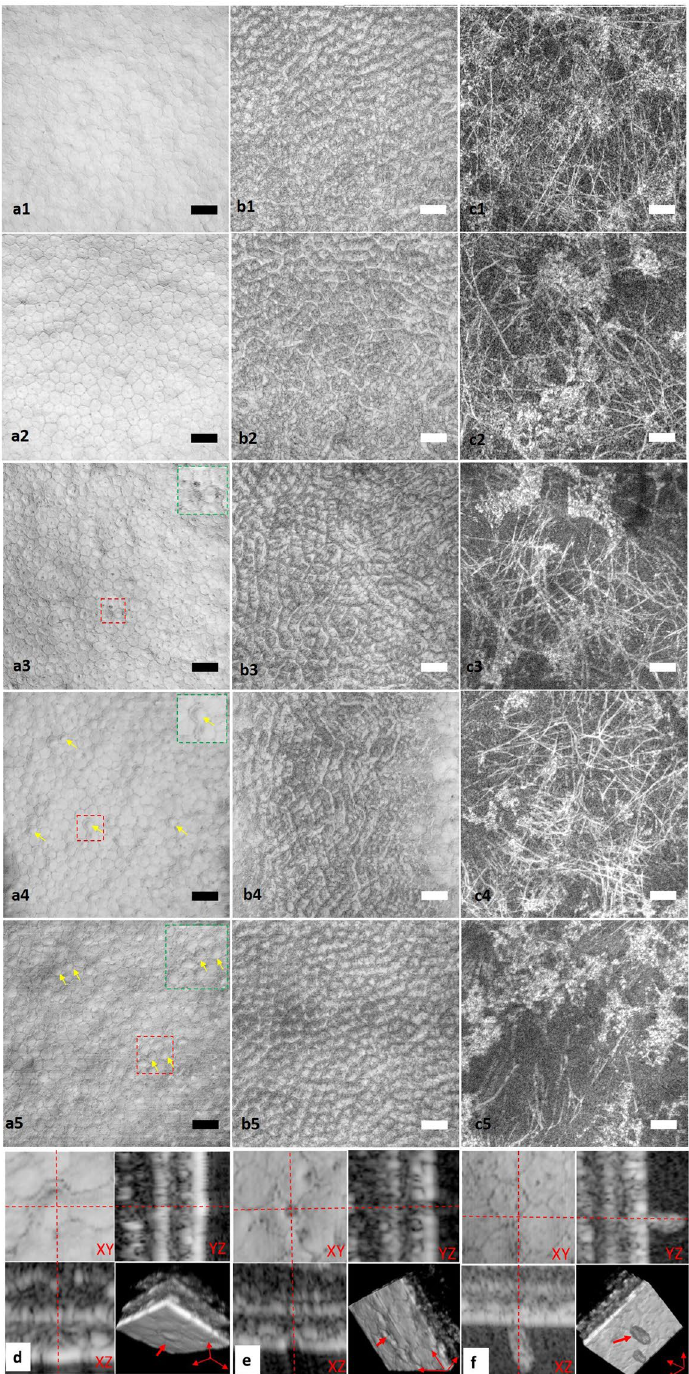
Figure 4. Longitudinal ex vivo observation of rat central cornea with µ OCT. En face views taken at < 5 mins ( a1 – c1 ), 2 h ( a2 – c2 ), 4 h ( a3 – c3 ), 8 h ( a4 – c4 ) and 24 h ( a5 – c5 ). ( a1 – a5 ) En face view of apical side of endothelial cells. Green square insets are zoomed-in view of red square areas in ( a3 , a4 and a5 ), respectively. Yellow arrows in ( a4 and a5 ) indicate endothelial cell swelling, which changed the cell surface from flat to dome-shaped. ( b1 – b5 ) En face view of the basolateral surface of endothelial cells and the interface between endothelium and Descemet’s membrane. A high scattering lattice was detectable at all these time points. ( c1 – c5 ) En face view of posterior stroma. Highly reflective collagen fibres and keratocytes are both visible at different time points, whereas the density of collagen fibres appears to decrease at 24 hours after sacrifice. ( d ) 3D view of deformation of endothelial cells. Red arrow indicates dome-shaped deformation of endothelial cells at the apical surface. ( e ) 3D view of endothelial defect (red arrows). ( f ) 3D view of leukocyte infiltration into the cornea from cell boundaries (red arrow) (Scale bar = 50 µ